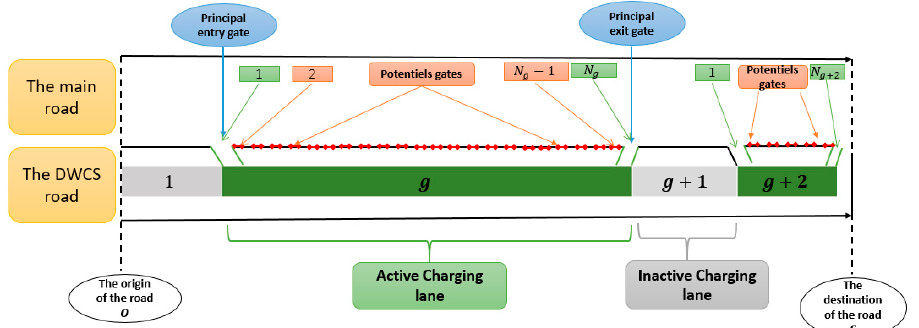
Figure 7. Highway with potential gates.